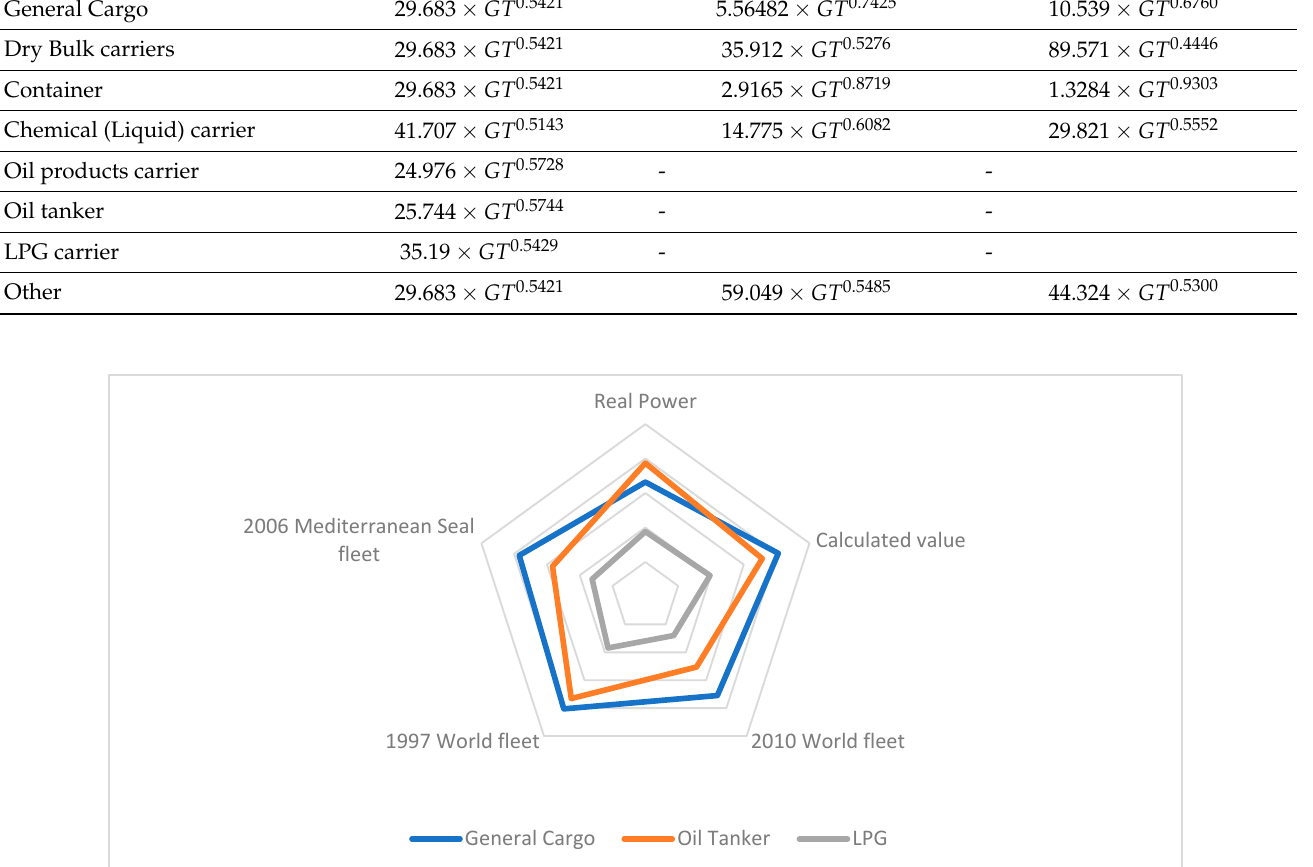
Figure 9. Comparison of non-linear regression of engine power.